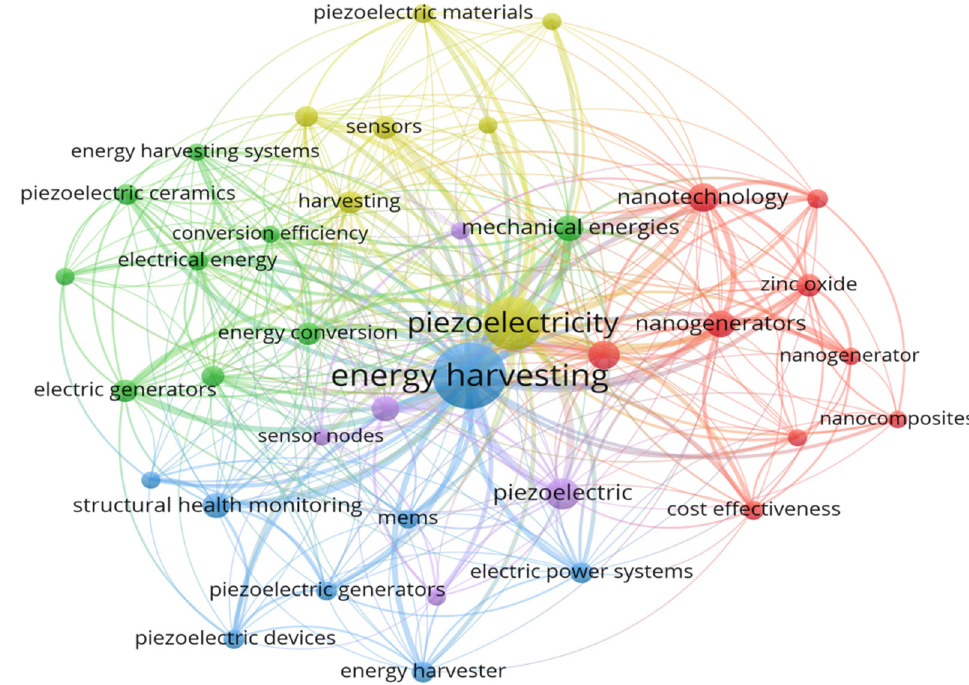
Figure 9. Visualization for the keywords.